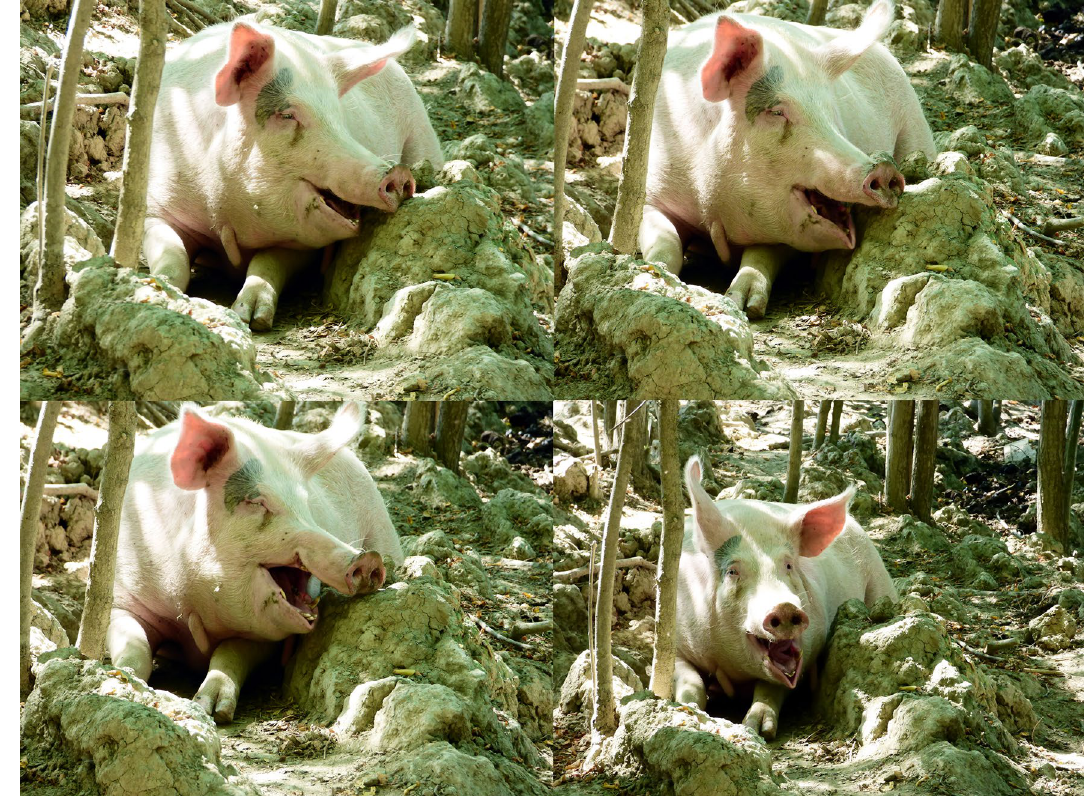
Figure 1. Part of a yawning sequence in Sus scrofa (Large White breed). Photo: Ivan Norscia (Camera: Panasonic Lumix